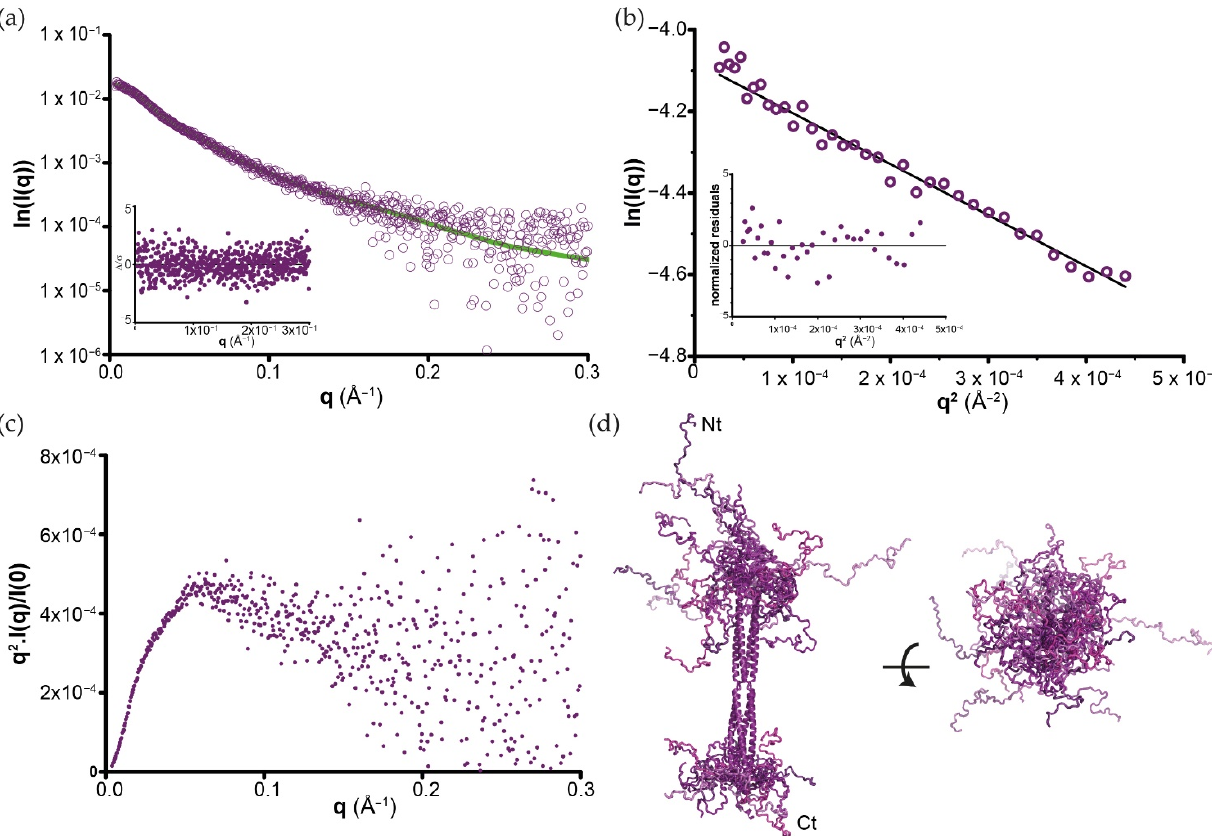
Figure 5. Flexibility analysis of BoDV-1 full-length P. ( a ) Experimental SAXS diffusion curve (deep- purple circles) of P FULL overlaid with the averaged SAXS curves (green) calculated from the EOM ensemble shown in panel ( d ). ( b ) Guinier extrapolation for the determination of the Rg. The smallest plot corresponds to the normalised residual. ( c ) Kratky plot showing the partially unfolded propensity of P FULL samples. ( d ) Conformational ensemble (6 of 10,000 conformers are shown; these models are perfectly representative of the whole population (Figure S6)) of P FULL obtained from the modelling procedure based on EOM. P OD X-ray structure is coloured deep purple, whereas the N- and C-terminal intrinsically disordered regions are coloured with six different shades of purples.